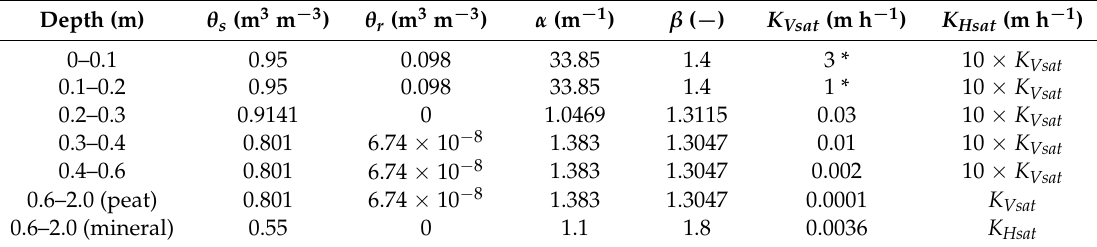
Table 1. Parameterization of the FLUSH model. Peat layer thickness varies between 0.8–2 m within the area. The parameters for the lowest peat layer are marked with tag ‘peat’. The parameters for the mineral soil under the peat layer are marked with tag ‘mineral’. Parameter values that were manually adjusted are marked with